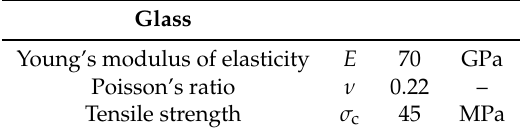
Table 3. Elastic material parameters and tensile strength of glass [51].